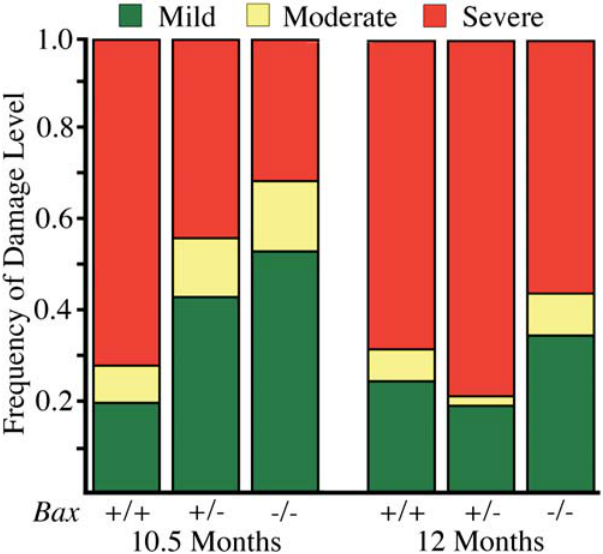
Figure 5. Glaucomatous Optic Nerve Degeneration Is Delayed in Bax - Deficient Mice BAX deficiency did not prevent glaucomatous axon degeneration. Nevertheless, the beneficial effect on RGC survival raised the possibility that it may have a protective effect on the axon and delay optic nerve damage. To assess this, three investigators masked to genotype determined the severity of optic nerve damage for mice of each Bax genotype at each age ( n = 49–71 per genotype at each age; see Materials and Methods). At 10.5 mo, both Bax +/ (cid:1) and Bax (cid:1) / (cid:1) mice had significantly less optic nerve damage than Bax +/+ mice. Mild damage was evident in 53% of Bax (cid:1) / (cid:1) and 44% of Bax +/ (cid:1) optic nerves, compared to only 20% of Bax +/+ ( p , 0.001 for both Bax +/ (cid:1) and Bax (cid:1) / (cid:1) compared to Bax +/+ ; Chi 2